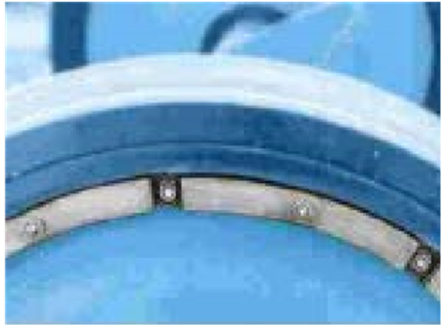
Figure 2. Locomotive wheel with tuned mass damper [26].